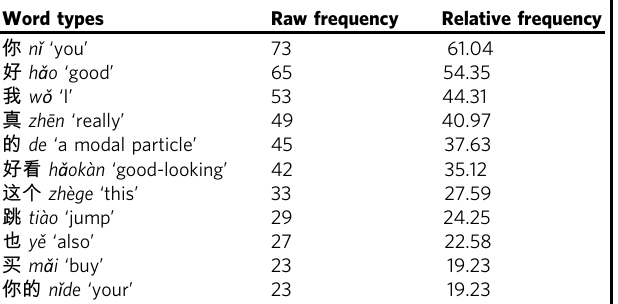
Table 4 Top 10 words in boys ’ imitated feminine speech. Word types